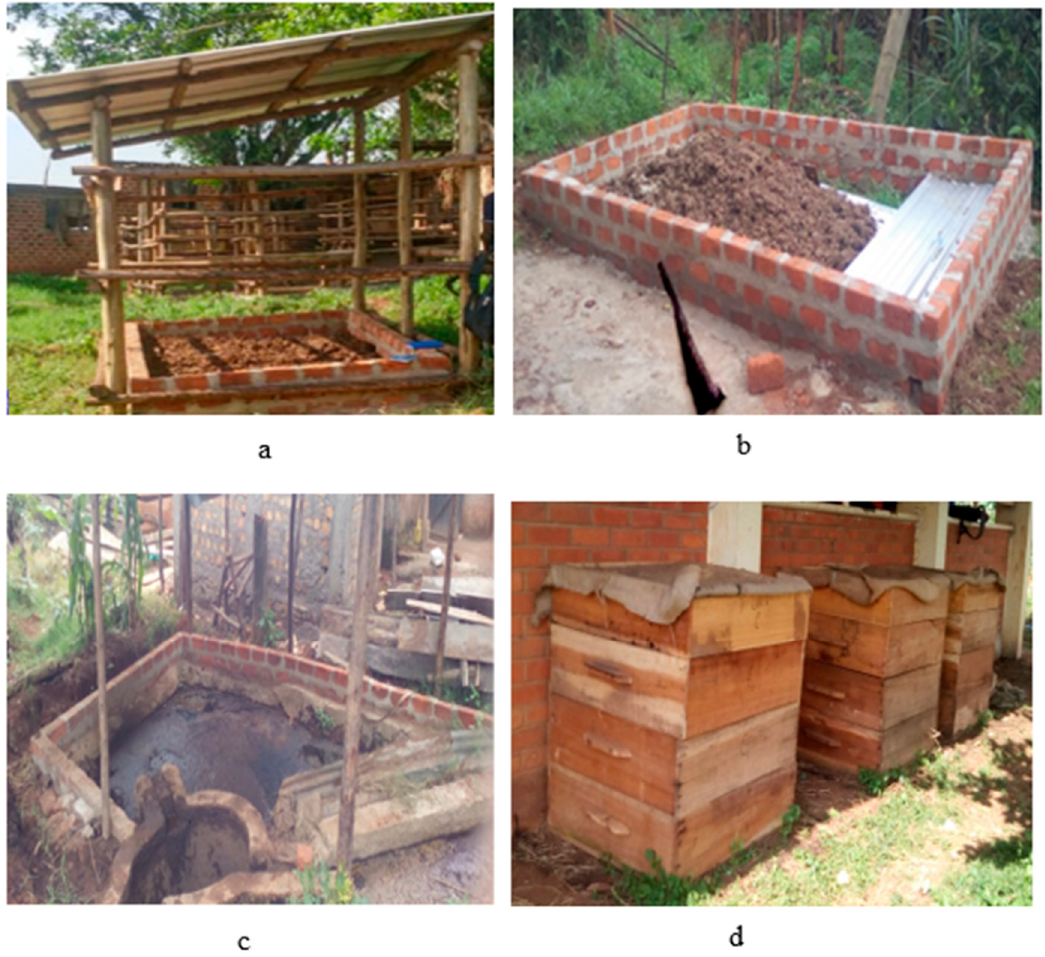
Figure 1. Different manure management technologies ( a ) cattle manure under shade, ( b ) cattle manure in the open, ( c ) cattle manure slurry under the shade, and ( d ) vermicomposting